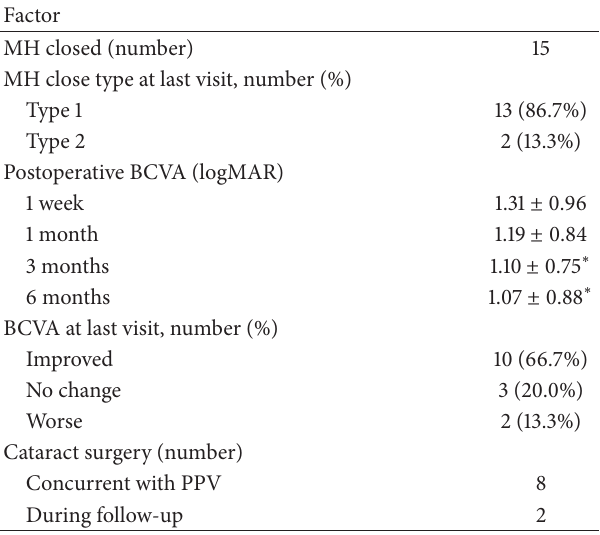
Table 2: Surgical results among all cases ( 𝑛 = 15 ).